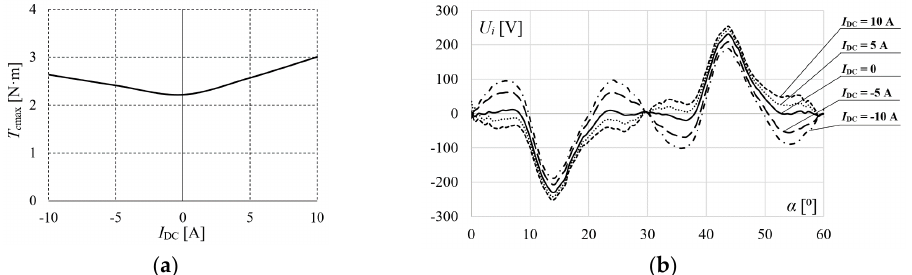
Figure 20. ( a ) Maximum value of the cogging torque depending on the current in the excitation coil; ( b ) Distribution of the back-EMF depending on the current in the excitation coil